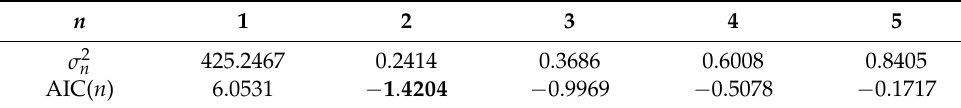
Table 1. AIC criterion values for n = 1, . . . , 5. n